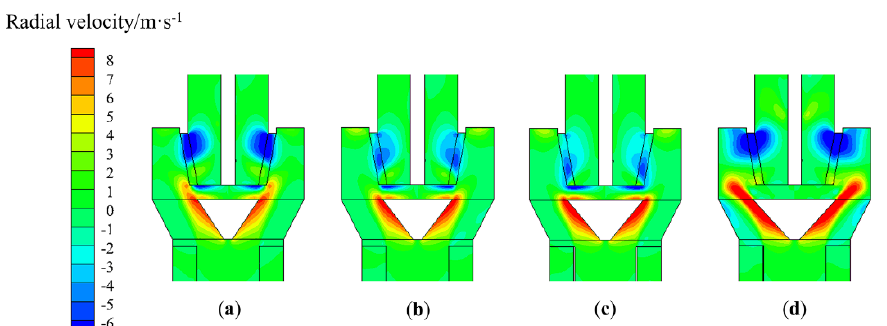
Figure 23. Effect of the diameter of the diversion cone on the radial velocity (T-C (1-0.8) , x = 0): ( a ) d = 176 mm, ( b ) d = 198 mm, ( c ) d = 220 mm, and ( d ) d = 242 mm.